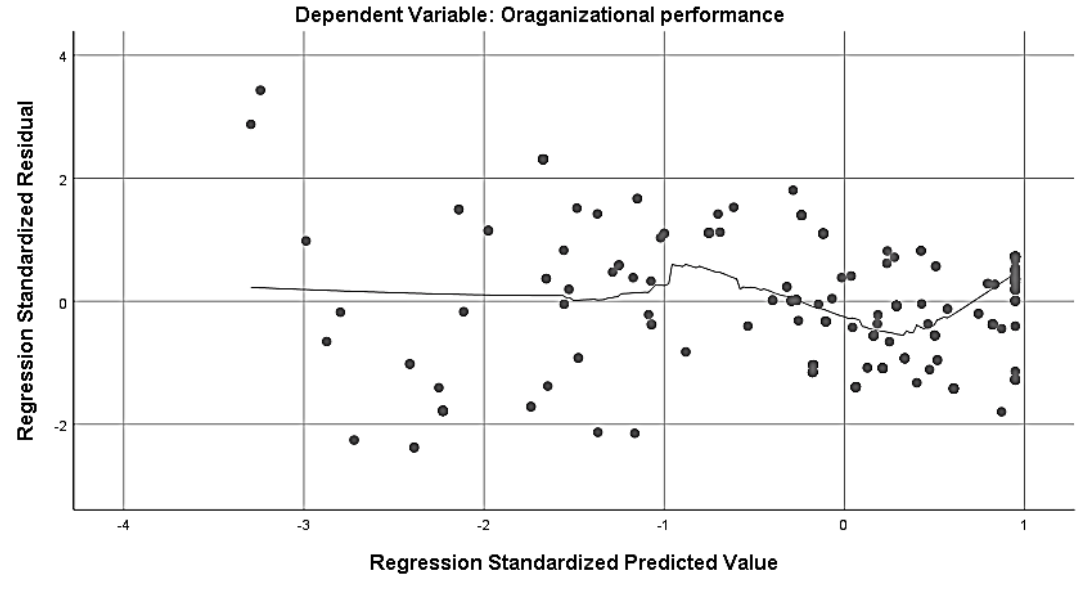
Figure 5. Simple scatter of organizational performance by use of social media.